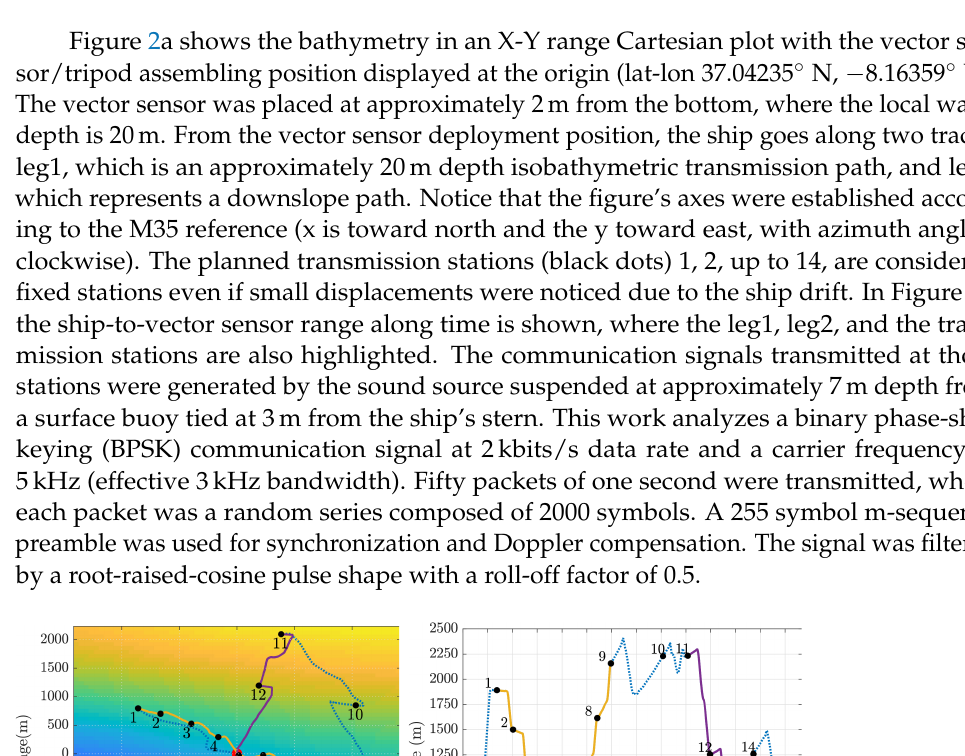
Figure 1. EMSO’21 experiment: satellite view with the ship sailing route and vector sensor posi- tioning (red dot) ( a ); used ship ( b ); Lubell sound source ( c ); M35 vector sensor on top of the tripod, with the autonomous recorder at one of the tripod’s legs ( d ).